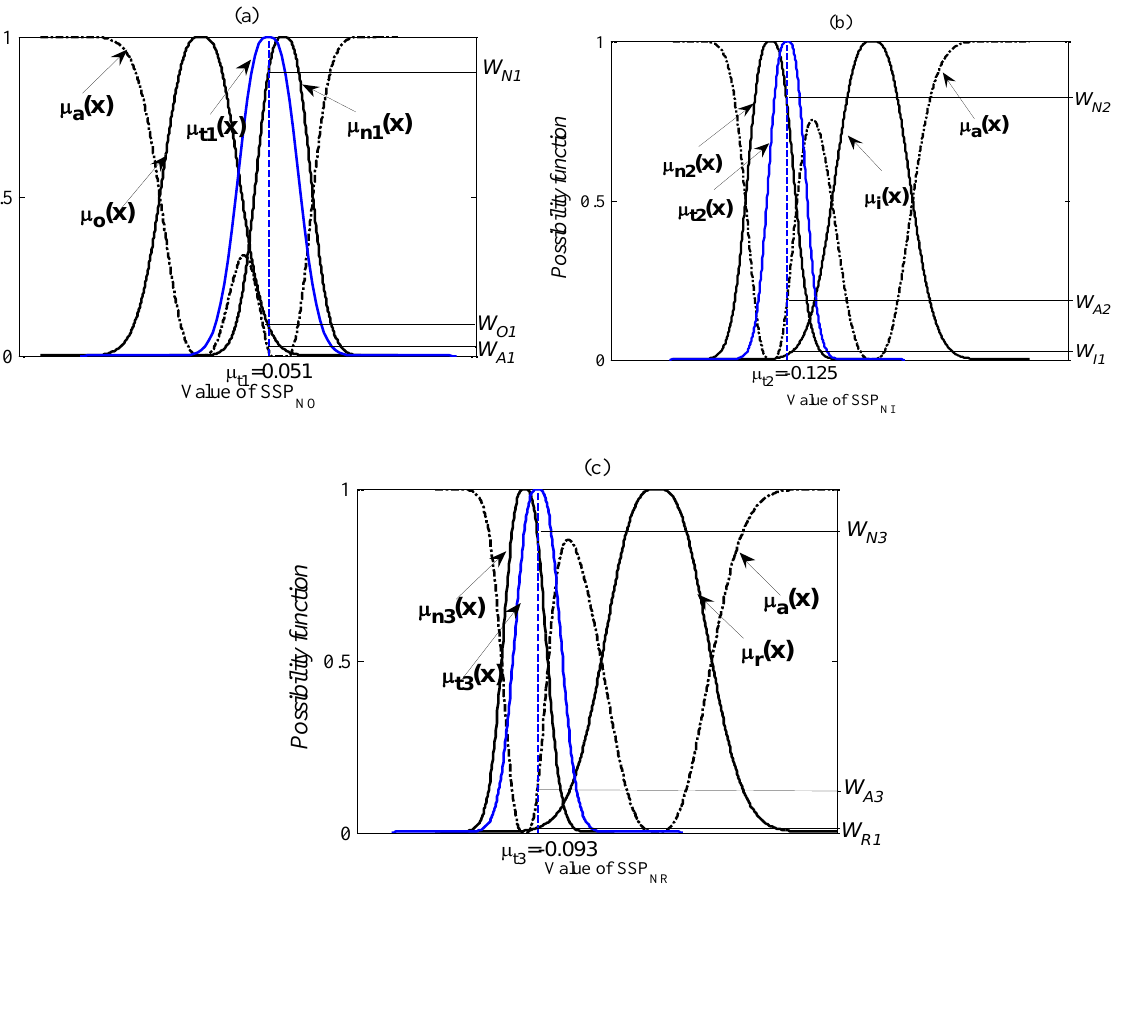
Figure 16. The practical diagnosis examples for the test